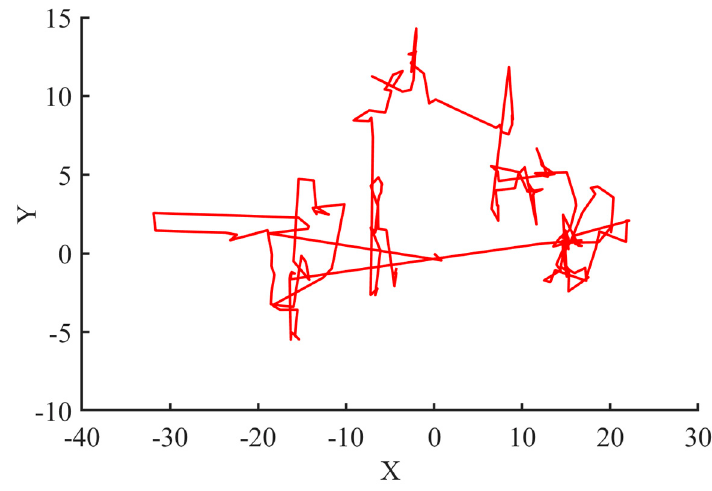
Figure 1. 2-Dimensional Levy random walk along X and Y axis.